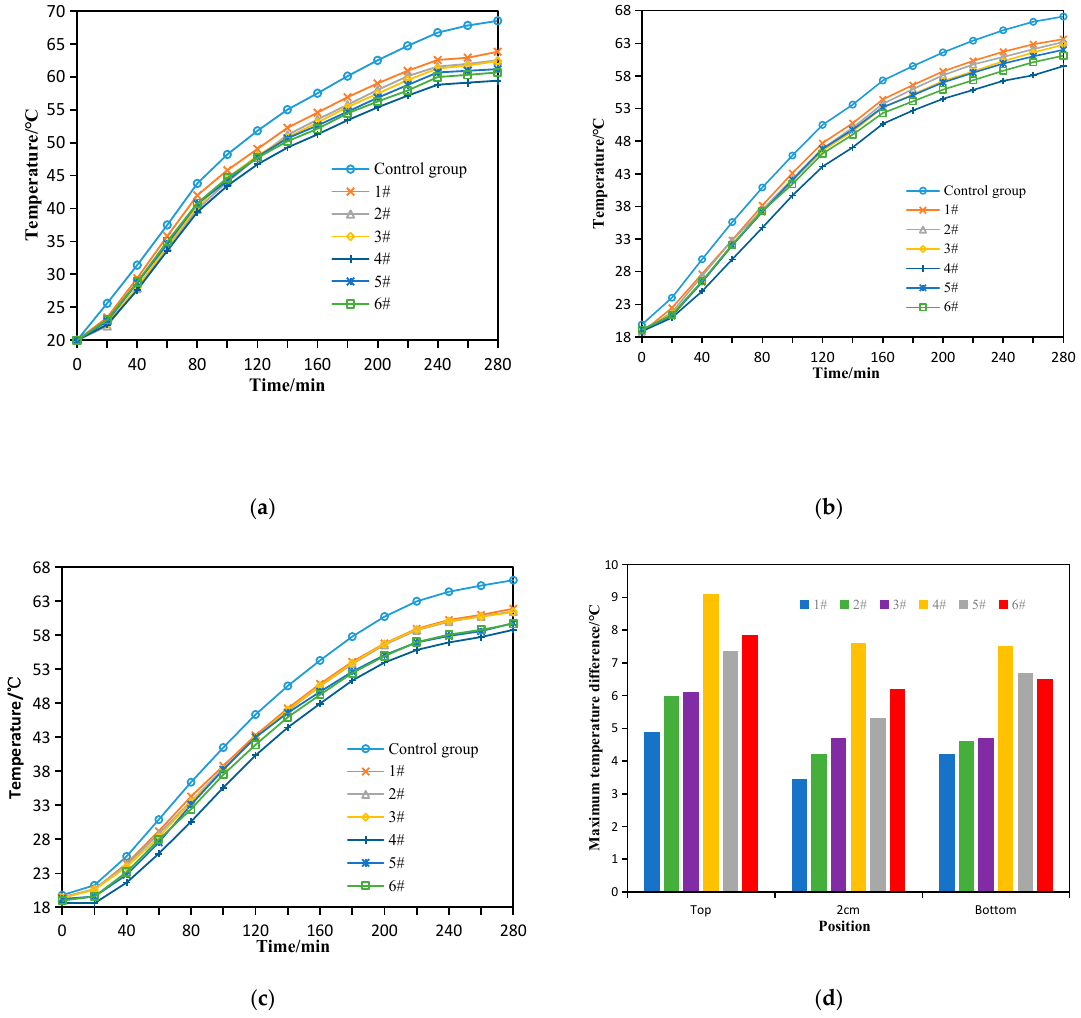
Figure 12. Cooling performance of coatings with different ratios: ( a ) The upper surface temperature of the specimen; ( b ) Temperature at 2 cm of the specimen; ( c ) Temperature at the bottom of the specimen; ( d ) Maximum temperature difference with the control group.